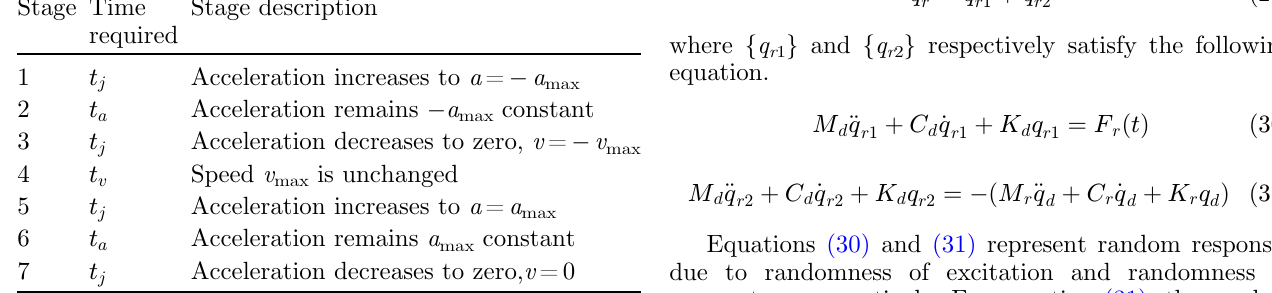
Table 1. Stage division of elevator operation state curve. Stage Time Stage description required